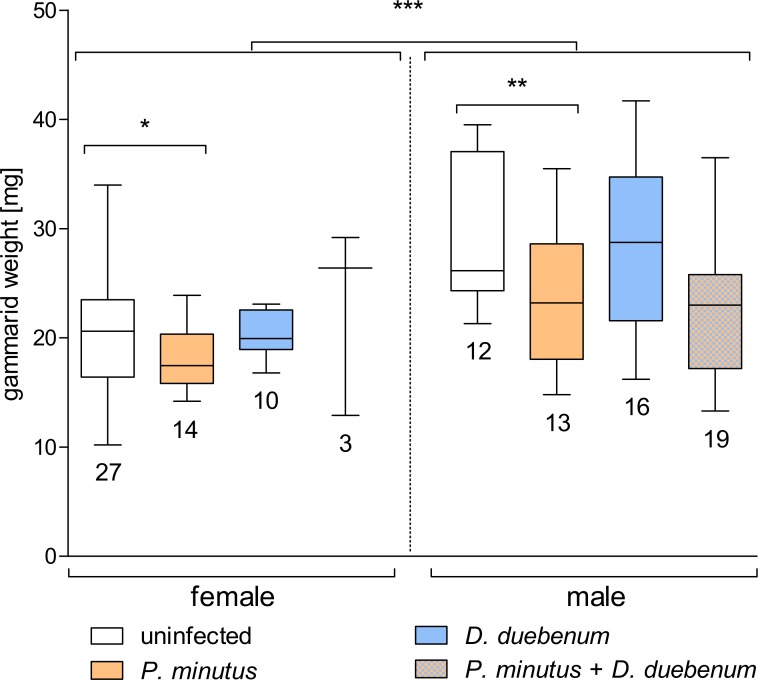
Box plot of gammarid weight depending on infection and sex.Numbers below boxes show number of gammarids. Asterisks indicate significant differences.